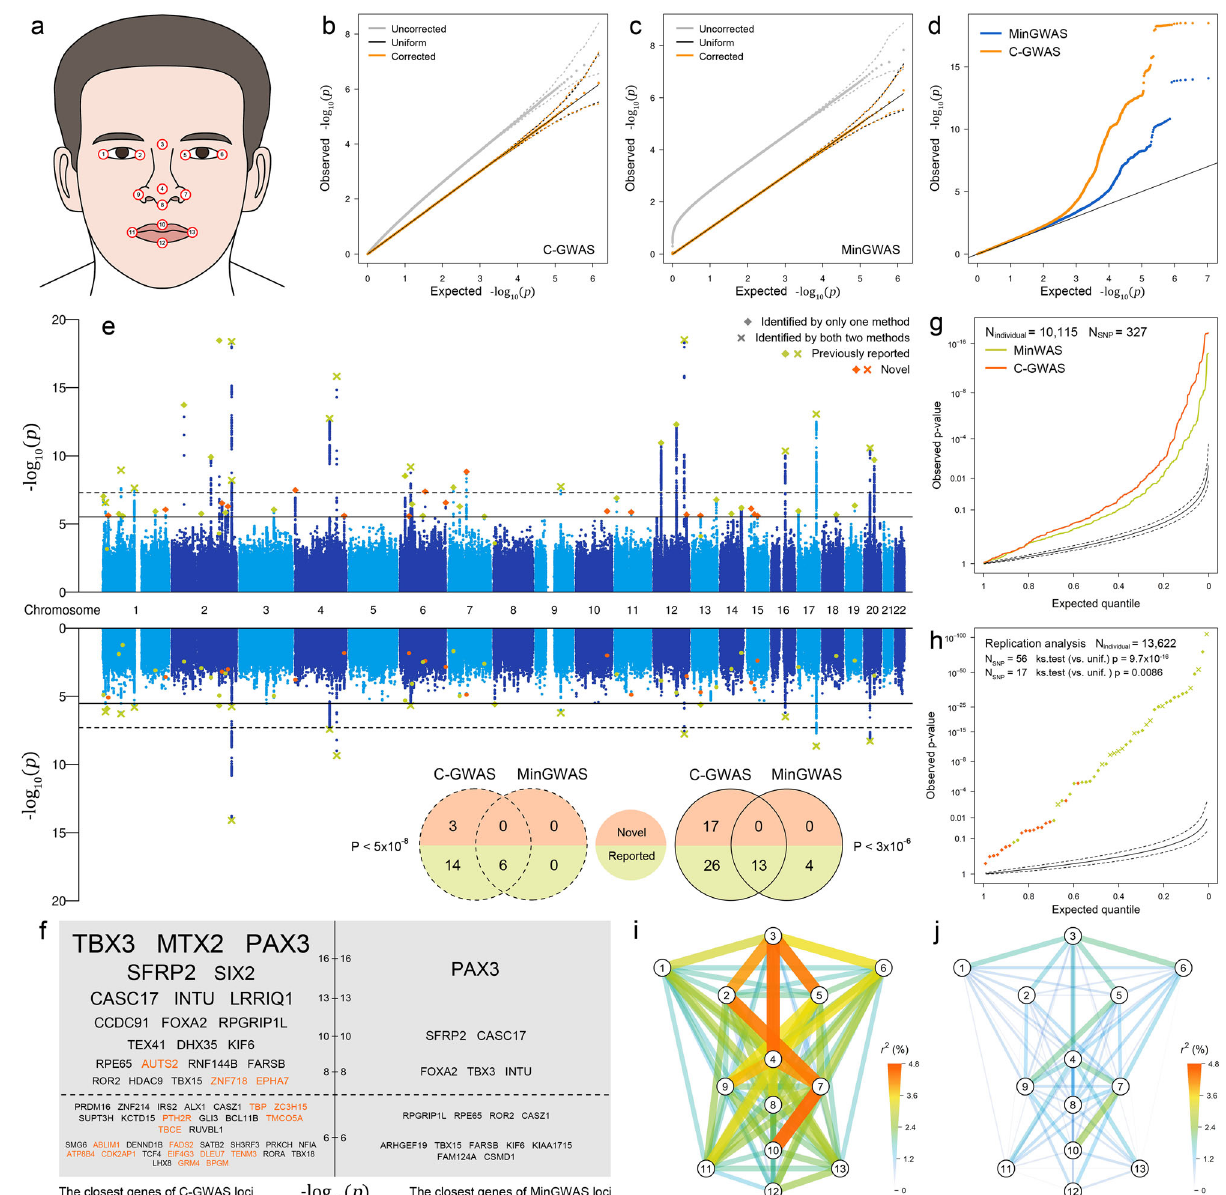
Fig.4|C-GWASanalysisof78correlatedfacialtraitsandreplication. C-GWASis applied to combine summarystatistics of 78GWASsbasedon 10,115 samples from four European cohorts 4 . a The 78 correlated facial traits were derived as the pair- wiseEuclideandistancesbetween13well-de fi nedfaciallandmarks. b , c Asimulation analysis derived the null distributions of C-GWAS and MinGWAS in terms of crude p -values(gray)and p -valuescalibratedusing getCoef (orange),whicharecompared with the uniform distribution (black). Median values and 95% intervals at all quantiles are indicated using dots and dashed lines. After distribution calibration, the C-GWAS results (upper part of e ) and the MinGWAS p -values (lower part of e ) are plotted using an overlayed Q – Q plot ( d ) and Miami plot ( e ). The study-wide signi fi cance threshold ( p = 5 × 10 − 8 ) is indicated using dashed lines and the study-